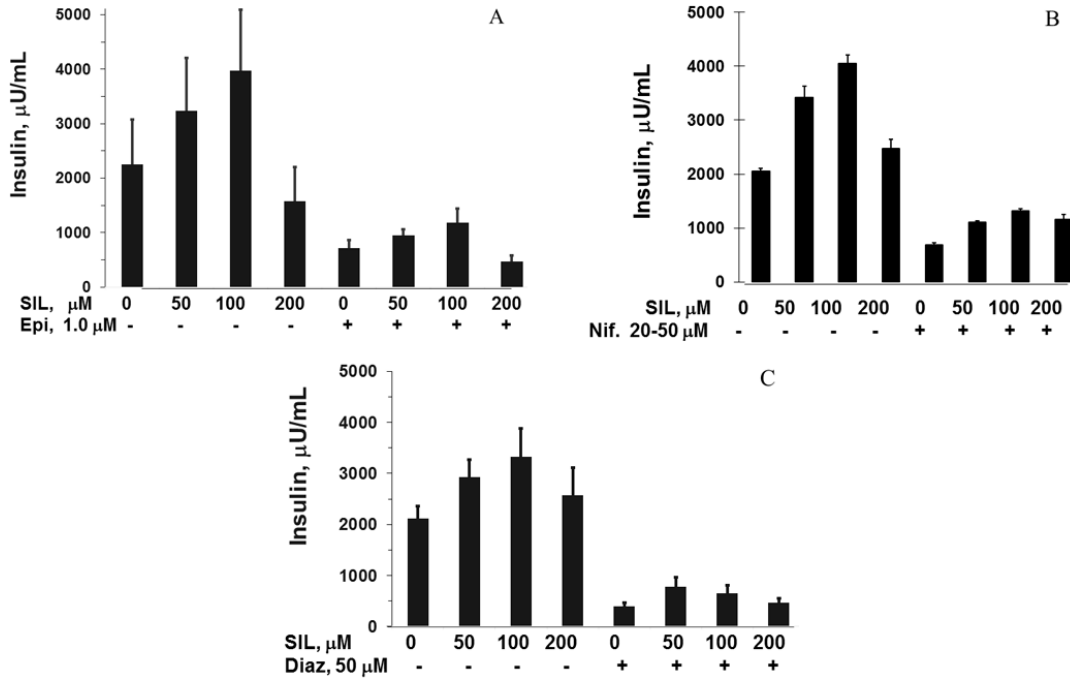
Figure 3. Insulin secretory responses from HIT-T15 cells in 2 h static incubations containing 11.1 mM glucose in increasing concentrations of SIL with and without three inhibitors of exocytosis.